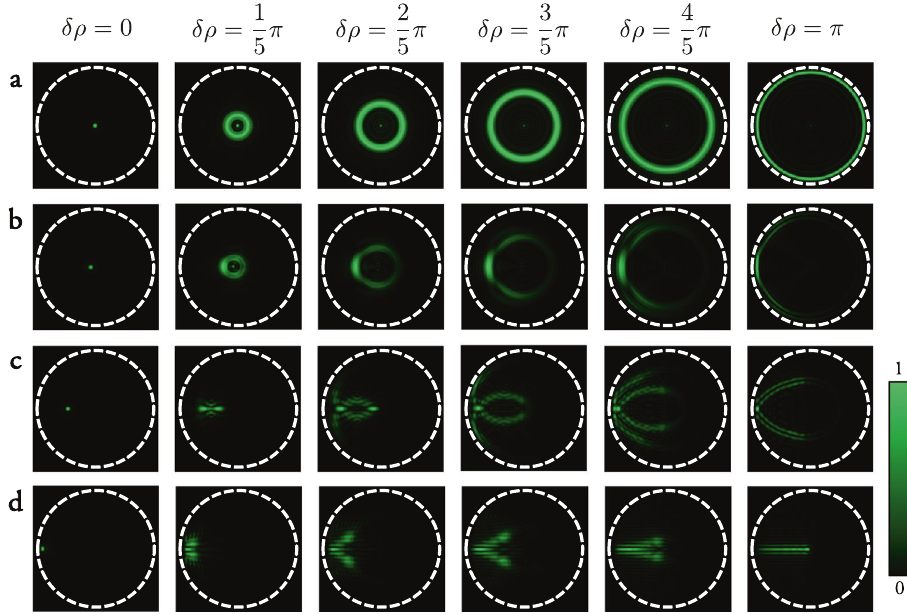
Fig. 2 The quasi-radial memory effect in MMFs. Each row shows simulations of a sequence of distal intensity patterns obtained by applying an input modulation O = PMP − 1 using M = diag[ e i p δρ ], for increasing δρ , where the initial distal fi eld (left most panel) is a diffraction limited spot at four different radial coordinates: on the fi bre axis ( a ), just off fi bre axis ( b ), midway between fi bre axis and core-cladding boundary ( c ), and near core-cladding boundary ( d ). The scale-bar indicates the relative intensity within each panel. We see a variety of different predominantly radial transformations take place. We emphasise that all of these transformations are independent of the length of the fi bre (i.e., independent of the complex values of the elements of D ). We also note that if the initial spot position is rotated about the fi bre axis, so are these output fi elds, by virtue of the rotational memory effect 35